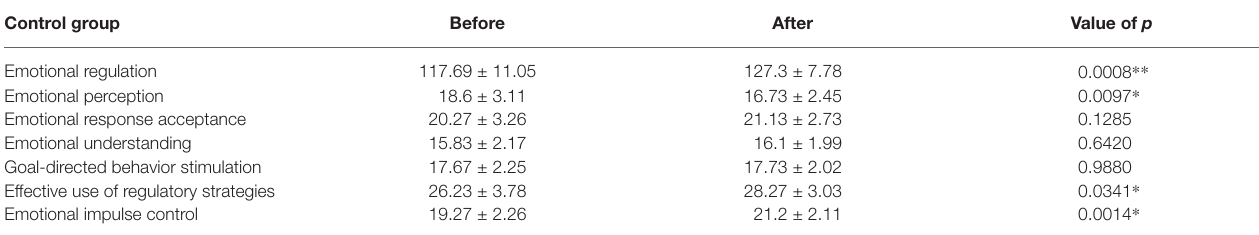
TABLE 3 | Dimension data of DERS scale of the control group before and after the intervention. Control group Before After